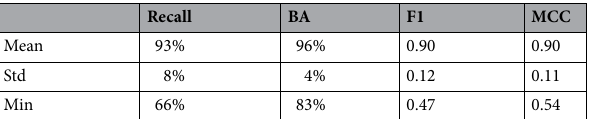
Table 1. Model performance. The mean, standard deviation (Std) and minimum (Min) values are reported for multiple metrics including recall, BA, F1 score, and MCC across the 218 RF